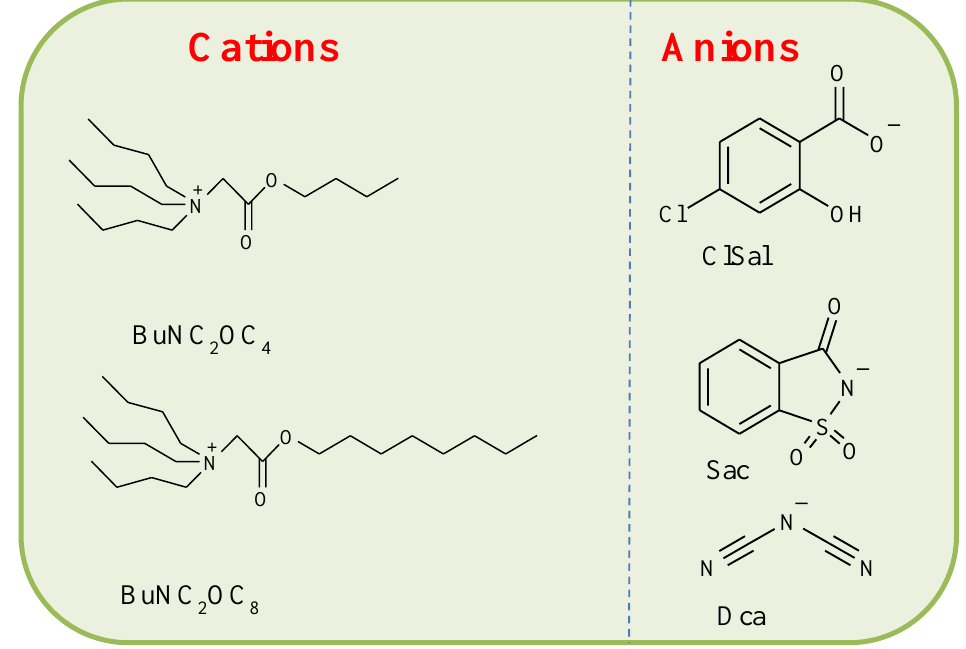
Figure 1. Structure of different analogues of glycine betaine based ionic liquids used in this study.